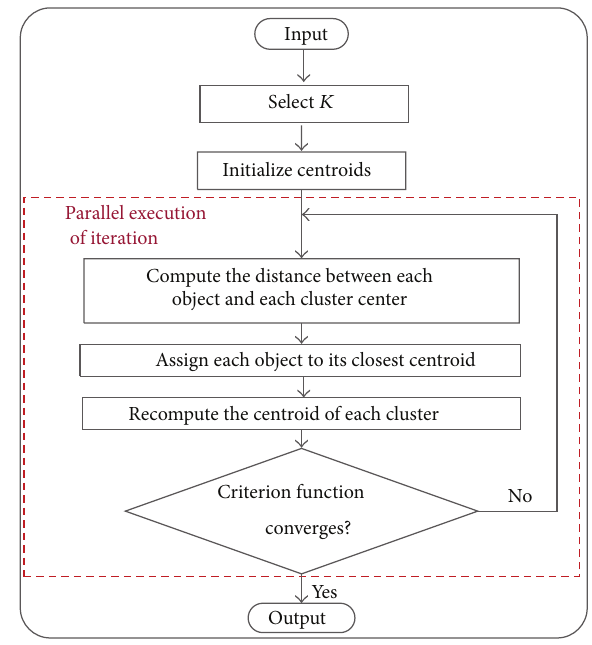
Figure 5: Process and framework of the DTSAD method. objects as initial centroids, where 𝐾 is the number of desired clusters. Then, each of the remaining objects is assigned